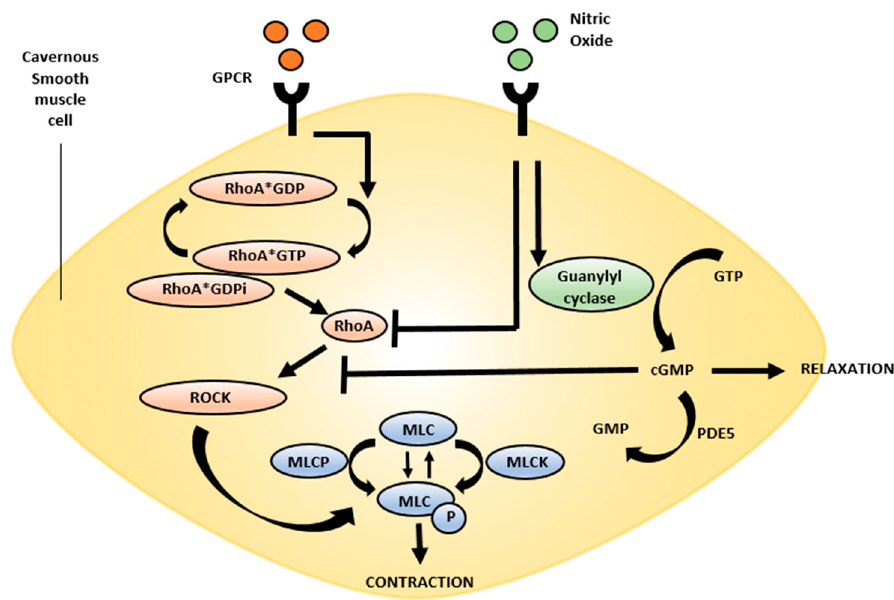
Figure 2. RhoA/ROCK pathway: Ligand binding to G-protein coupled receptors results in conversion of RhoA-GTP to RhoA-GDP. RhoA-GTP dissociates from RhoA-GDPi, allowing RhoA to bind downstream targets, including ROCK. ROCK autophosphorylates to become active and subsequently phosphorylates MLCP, rendering it inactive and promoting smooth muscle contraction and maintenance of the flaccid penile state. NO promotes the conversion of GTP to cGMP by activating guanylyl cyclase. Both NO and cGMP can inhibit the activity of RhoA thereby promoting penile relaxation. GTP: guanosine-5 ′ -triphoshate; GDP: guanosine-diphosphate; GDPi: GDP dissociation inhibitor; ROCK: Rho-associated protein kinase; MCLP: myosin light chain phosphatase; NO: Nitric oxide; cGMP: cyclic guanosine monophosphate; GPCR: G Protein Coupled Receptor.